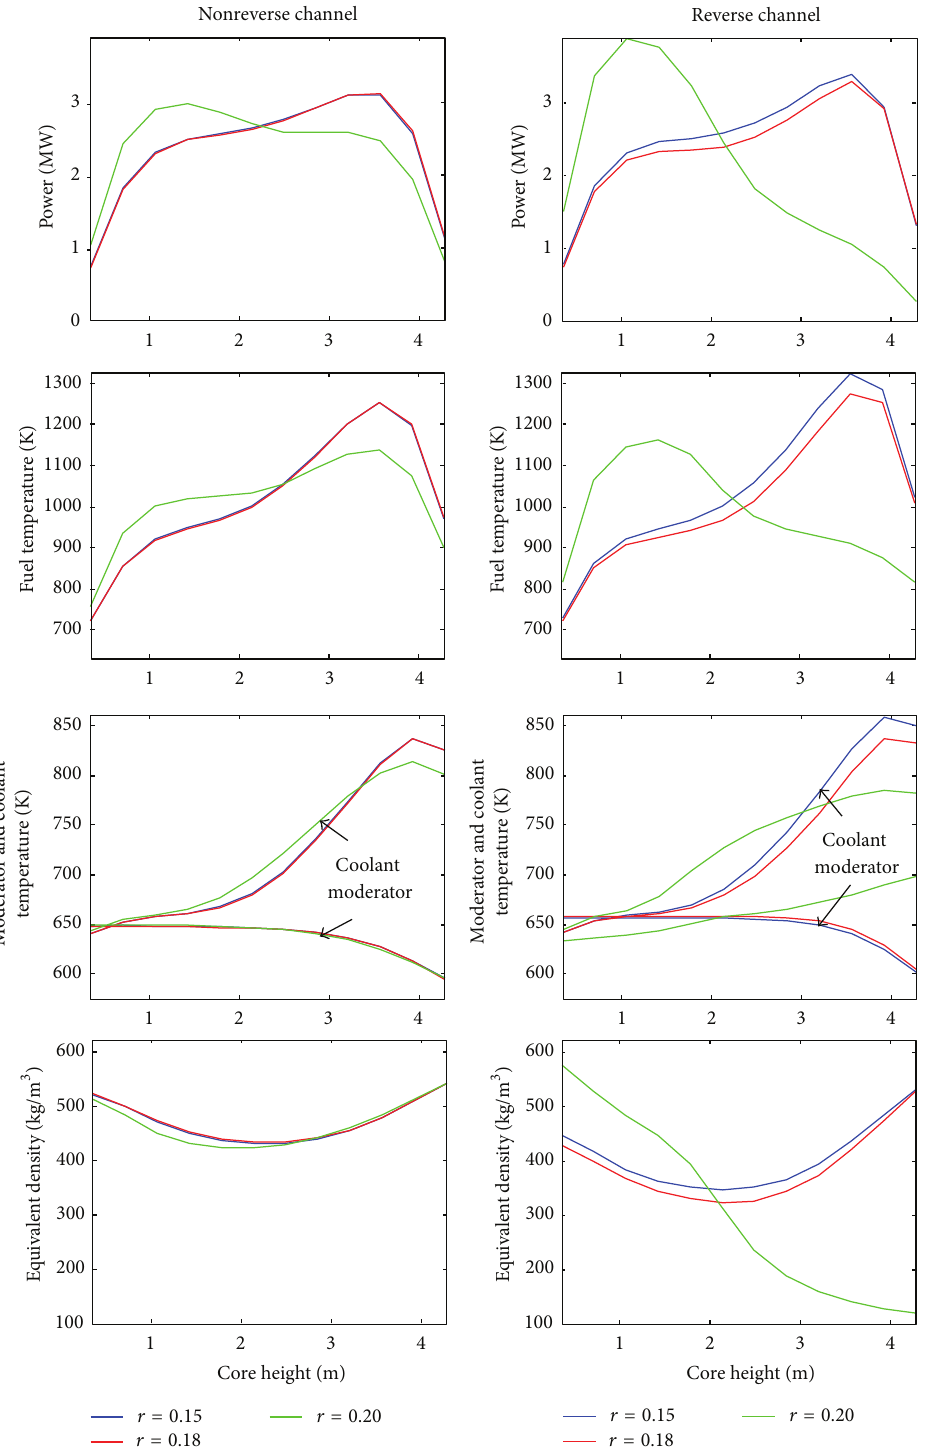
Figure 4: Power, fuel temperature, moderator and coolant temperature, and equivalent density profiles in three assemblies for three orifice